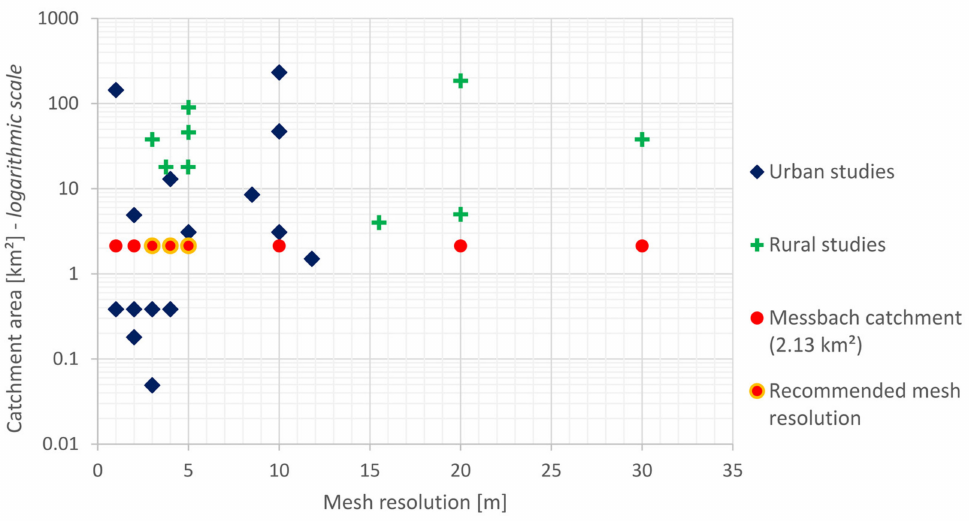
Figure 39. Spatial resolution and catchment size of the results of the literature review (summary of results of Tables 1 and 2) and evaluated and recommended mesh resolution (orange outlined dot) for HEC-RAS in the Messbach catchment, 2.13 km 2